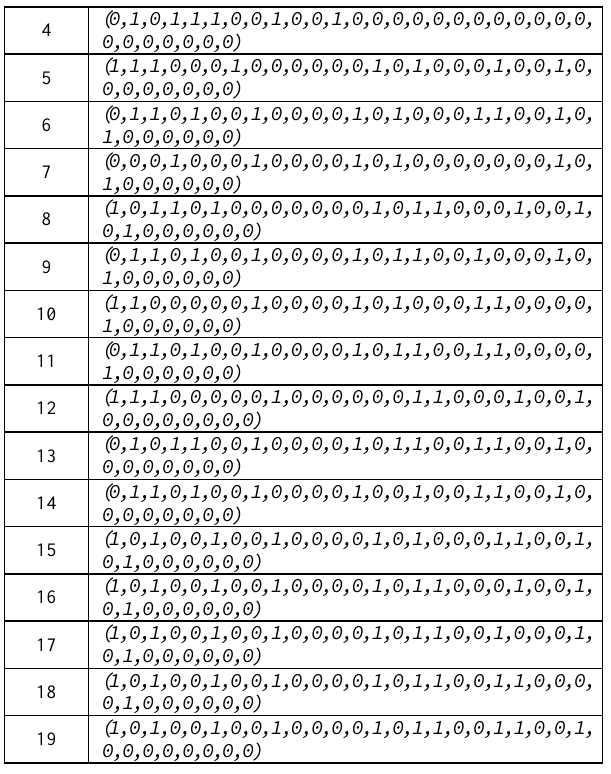
Table 2 : List of Injected Grain v0’s in vector (above). From Table 2, value of ( h i (x) ) in vector will be used to compute value of C={ p • h | p ∈ A 2 }.We construct matrix M d (h) by output of C for each injected Boolean function and we get [15x31] matrices. Table 3 show output of M d (h) . h i (x ) M d (h i